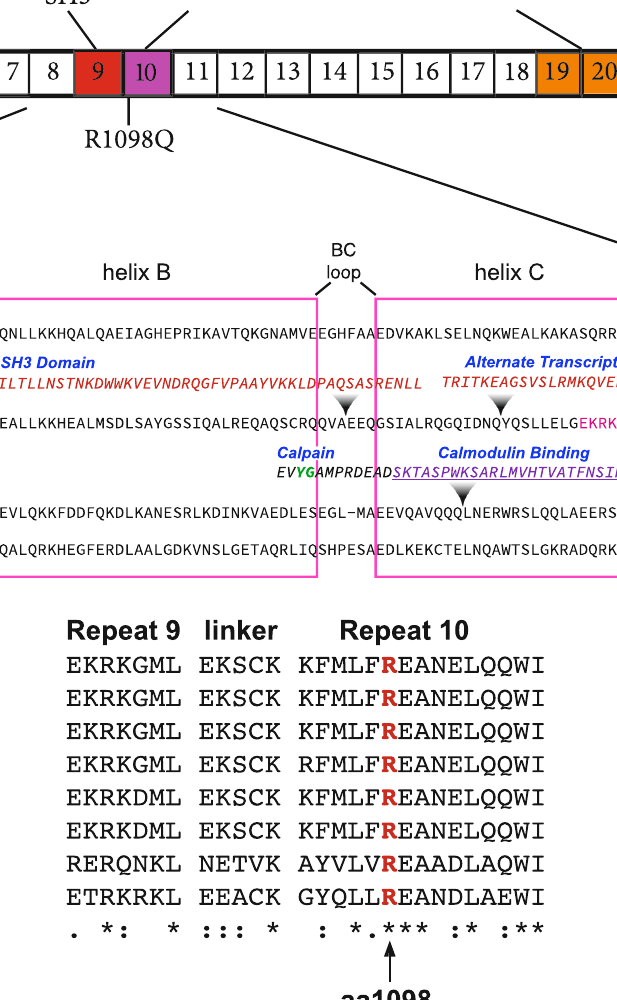
(P7) display subtle gross anomalies in their brain, including foliation of the cerebellum and convolutions in the cortex (Fig. 2, contrast with supplemental Fig. S2). By adulthood, the degree of cerebellar degeneration becomes profound, and correlates with the progressive decline in coordinated movement (supplemental Fig. S1). Histo- logically, alterations in the neonatal P7 brain are subtle and largely unapparent. Purkinje cells at this early age appear well developed and abundant, without obvious disruption of their dendrites or number. This is particu- larly apparent after immunostaining for βIII spectrin, a marker of PC’s in the cerebellum (Fig. 2a, inset; Fig. 3,